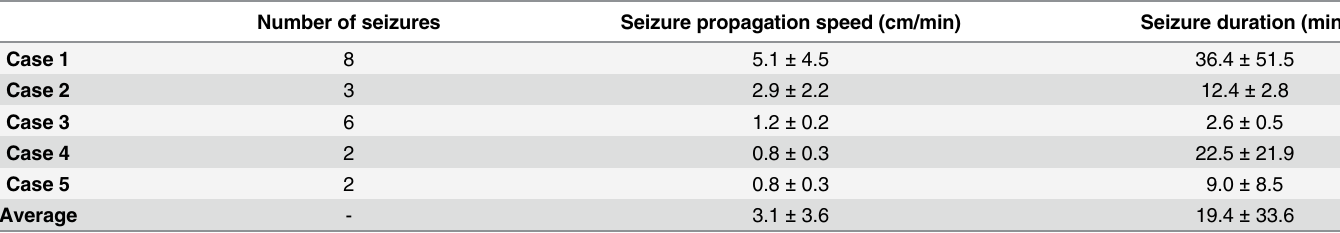
Table 2. Seizure propagation speed and duration.